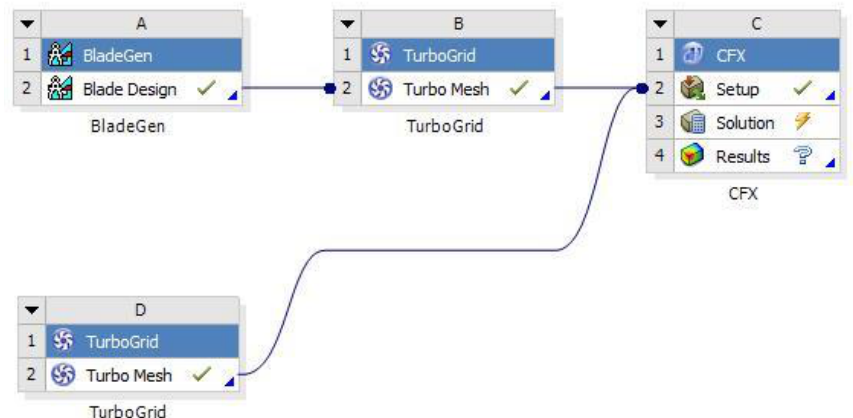
Figure 5. Optimization flow chart in the ANSYS Workbench.